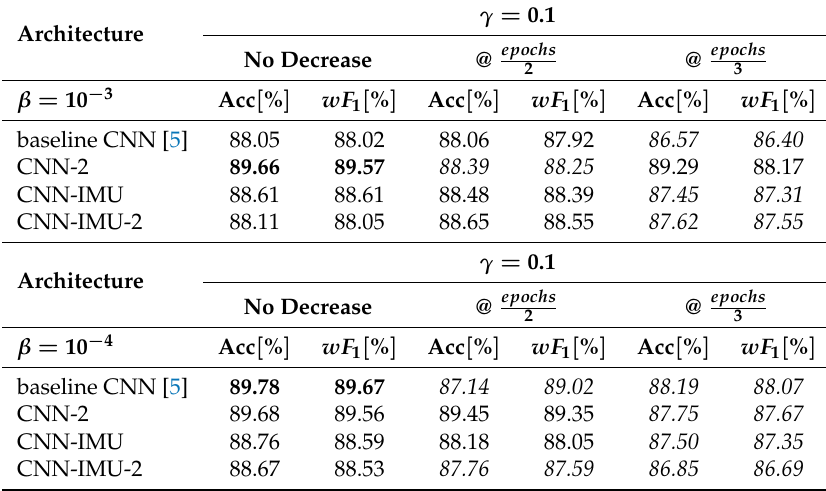
Table 8. Validation accuracies and Weighted F1 for the architectures on the Opportunity-Locomotion dataset when reductions of the learning rate during training are